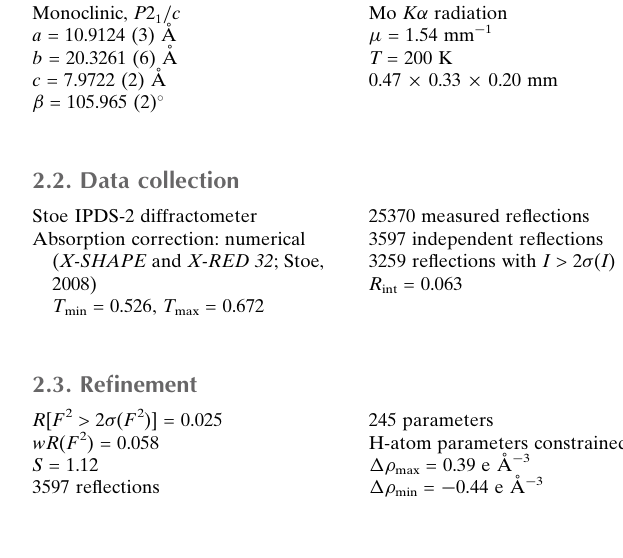
of the compound,